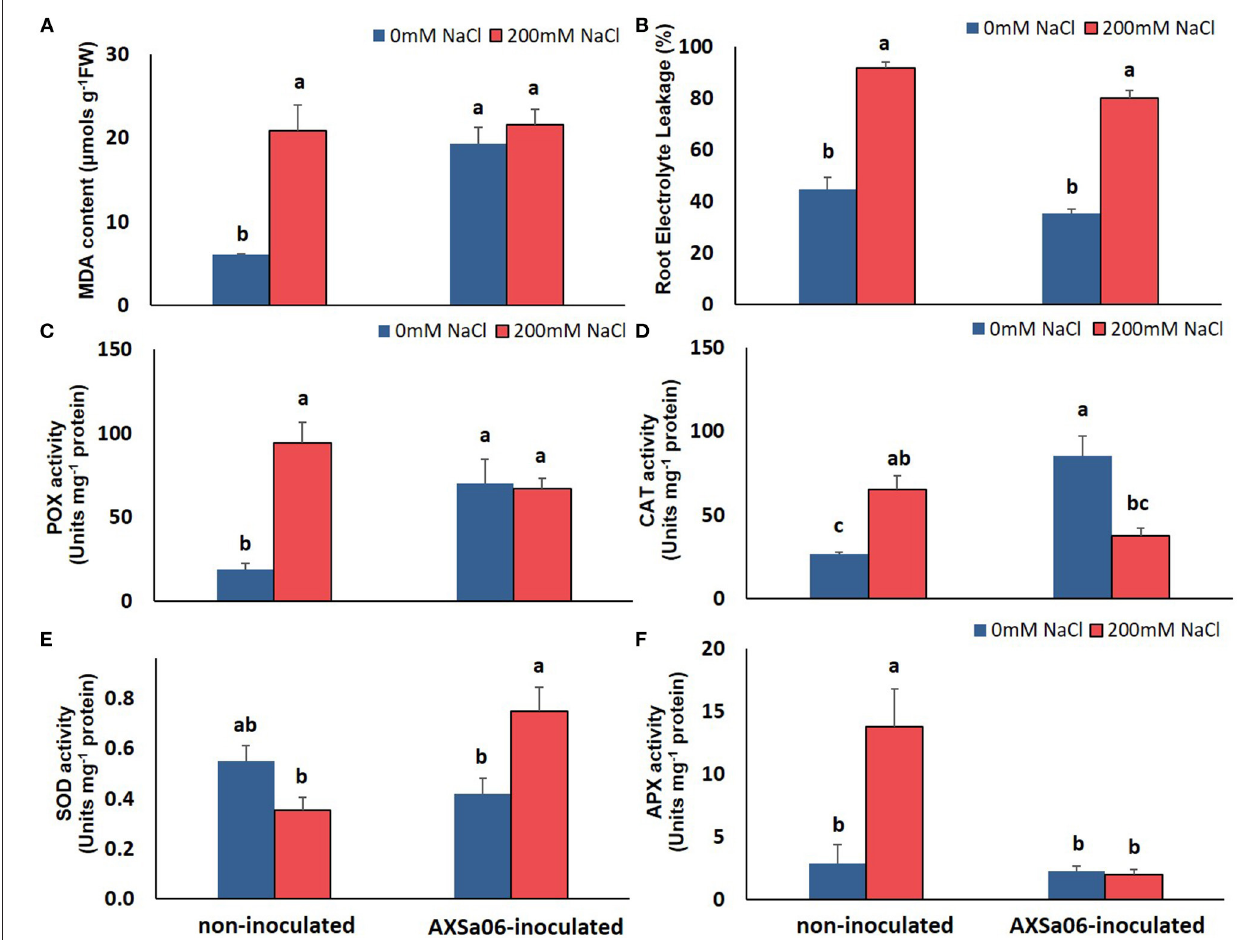
FIGURE 2 | Oxidative-related effect of AXSa06 ( Pseudomonas oryzihabitans ) seed inoculation on tomato seedlings treated with 200mM NaCl for 7 days: (A) MDA content ( µ mols g − 1 FW); (B) Root Electrolyte Leakage (%); (C) POX specific activity (Units mg − 1 protein); (D) CAT specific activity (Units mg − 1 protein); (E) SOD specific activity (Units mg − 1 protein); (F) APX specific activity (Units mg − 1 protein). Data are means of five biological replicates ± standard error. Different letters indicate statistically significant differences between treatments based on Duncan’s multiple range test ( P <